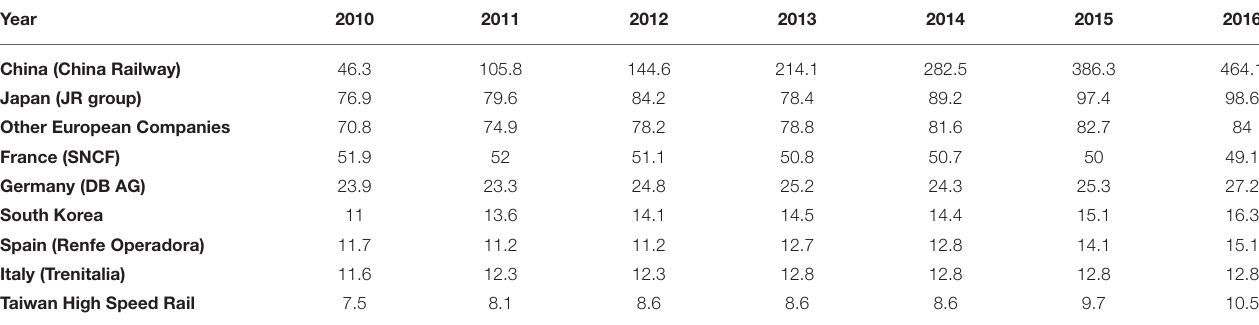
TABLE 2 | High Speed traffic in the world (billion of